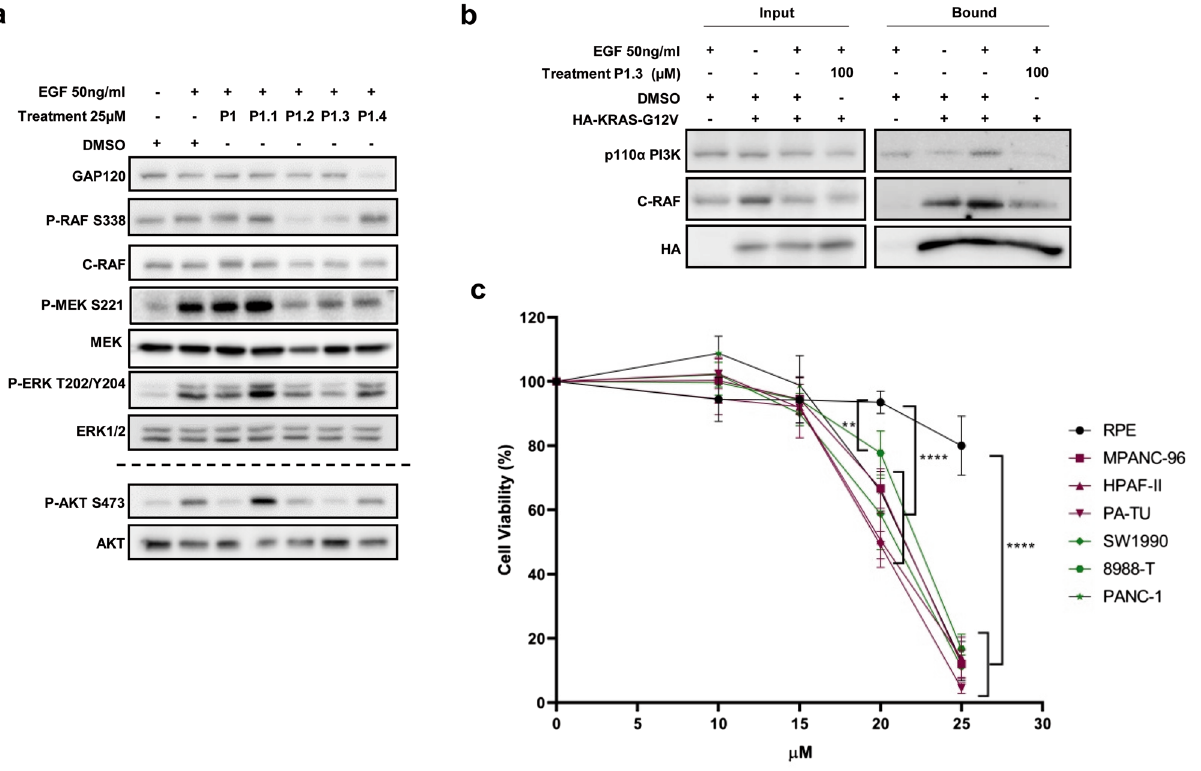
Figure 5. P1.3 reduces PI3K and c-RAF1 signalling and interaction with KRAS; and decreases pancreatic tumour cells but not normal cells viability. ( a ) hTERT-RPE starved cells were incubated with 25 µM of the indicated peptidomimetics for 2 h and the levels of activation of the RAF/MEK/ERK and PI3K/ AKT pathways after EGF stimulation for 10 min were studied by Western blot. Specific antibodies against the active phosphorylated and total proteins were used. GAP120 was utilized as a loading control. ( b ) Co-immunoprecipitation of HA-KRASG12V with C-RAF or with PI3K was analysed in starved HeLa cells expressing HA-KRASG12V after being incubated with 100 µM of P1.3 for 2 h, and EGF-stimulated for 10 min. IP was performed with anti-HA antibodies and Western blot of the bound and input fractions with anti- p110αPI3K and anti-C-RAF. ( c ) Effect of P1.3 on the cell viability of six pancreatic adenocarcinoma human cell lines (all harbouring oncogenic KRAS mutations) and of a non-transformed cell line (hTERT-RPE). Cells were treated with P1.3 in a dose range from 0 to 25 µM and incubated for 24 h, when cell viability was determined by MTS assay. Experiments ( a ) and ( c ) were repeated at least three times, and ( b ) once. Differences were assessed using one-way ANOVA and Tukey Multiple Comparisons Test and considered significant when p ≤